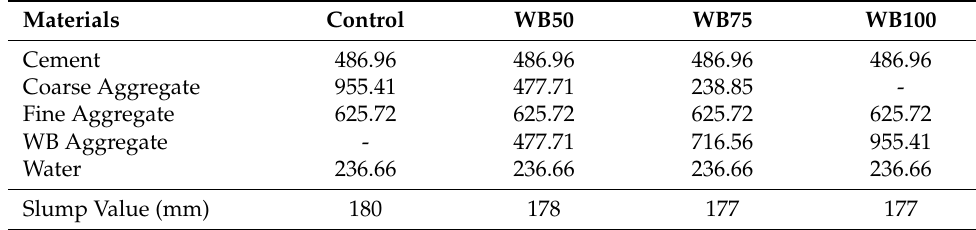
Table 2. Mix design of concrete (kg/m 3 ).